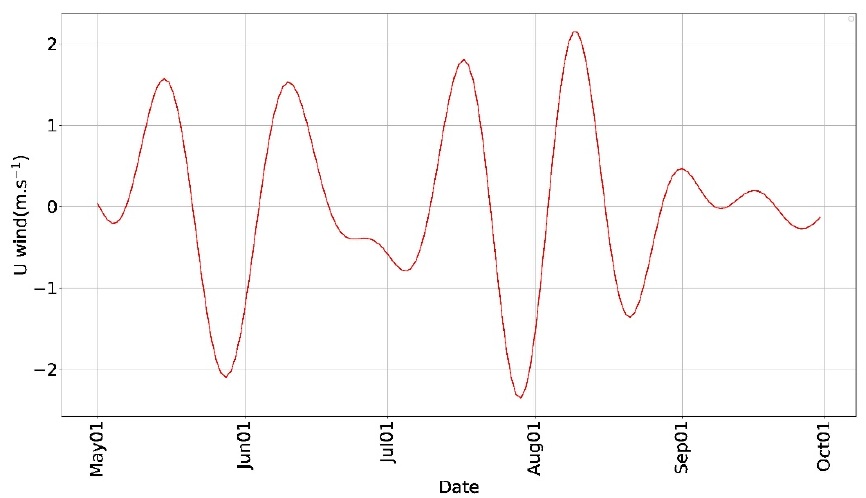
Figure 9. The 20–40 d bandpass filtered time curve of 850 hPa zonal wind over the north of the South China Sea (105~115° E, 12~20° N) during May–September 2014 (units: m s − 1 ). The low ‐ frequency zonal wind can strengthen the intensity and propagation of the monsoon surge. Thus, according to the 20–40 days filtered zonal wind on 850 hPa along 111° E in 2014 (Figure 10), the monsoon surge had an obvious northward propagation process from early to late July. In early July, the negative low ‐ frequency oscillation center in low ‐ latitude regions changed to a positive one, representing the emergence of a new